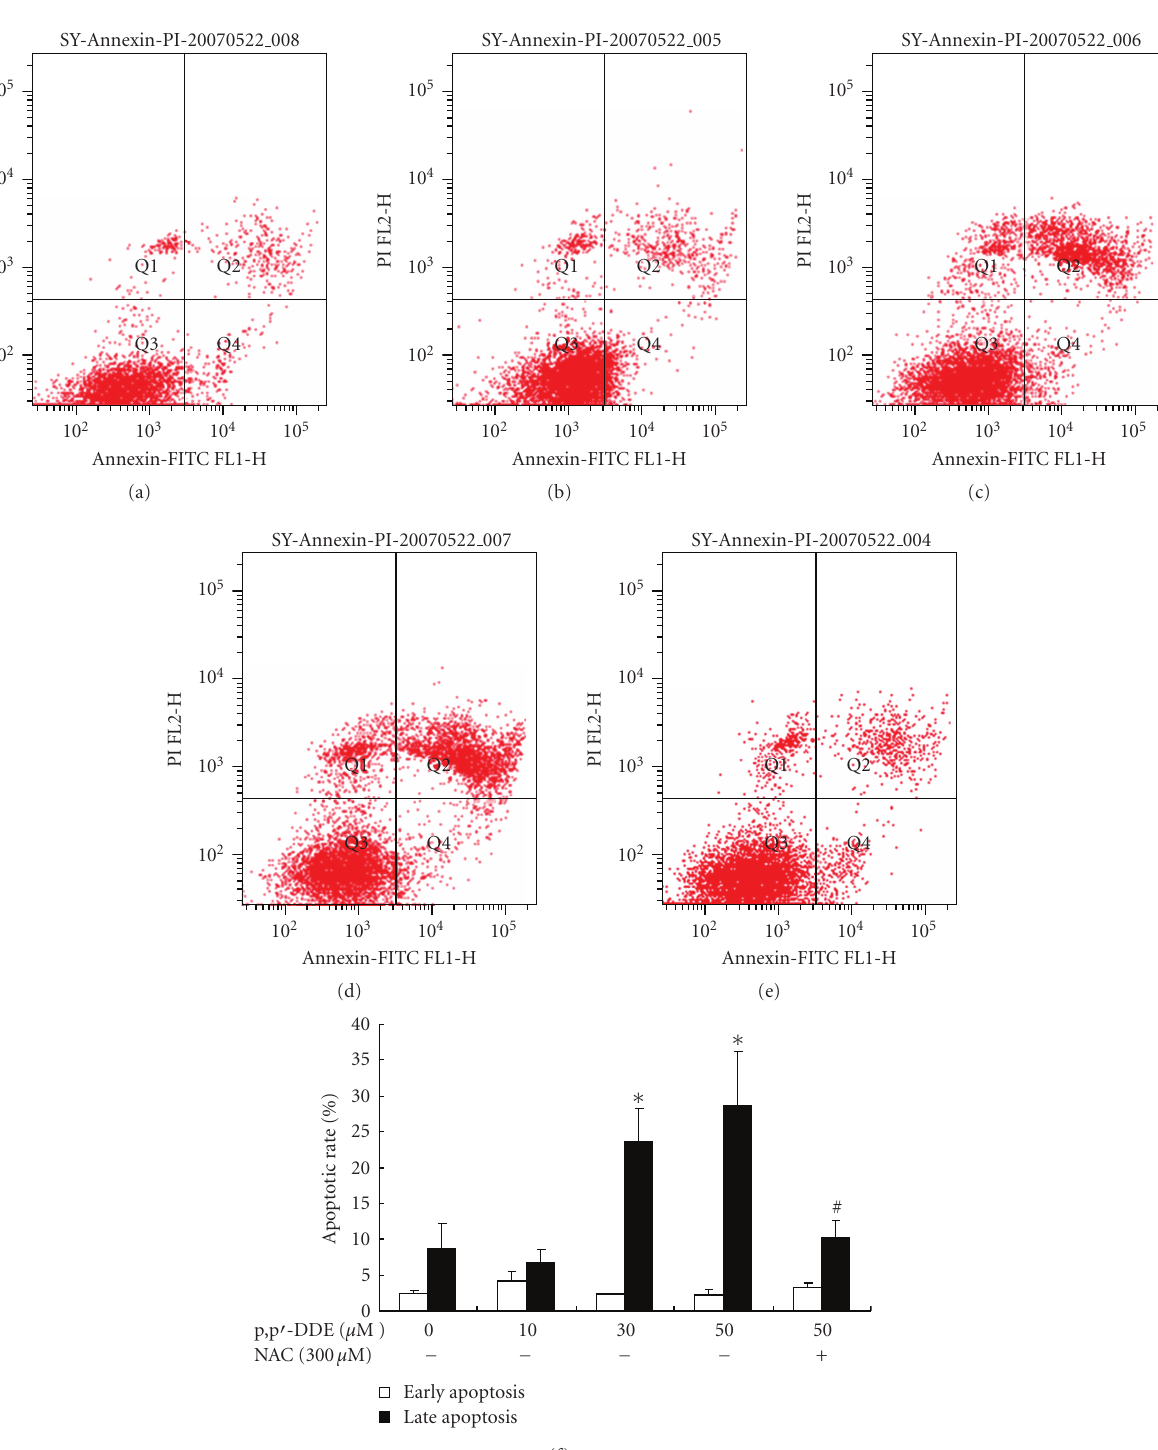
Figure 3: Representative plots of PI-Annexin staining of Sertoli cells treated with p,p (cid:2) -DDE with or without NAC. Sertoli cells were incubated with various concentrations of p,p (cid:2) -DDE (10, 30 or 50 μ M) for 24 hours. In other experiment, Sertoli cells were preincubated with 300 μ M NAC for 1 hour and followed by incubation with 50 μ M p,p (cid:2) -DDE for 24 hours. Then cell apoptosis was tested with flow cytometric analysis. (a)–(e) represented as treatment of 0 . 3% DMSO (a), 10 or 30 μ M p,p (cid:2) -DDE (b)–(c), 50 μ M p,p (cid:2) -DDE without or with NAC (d)–(e). (f) The apoptotic rate showed that 30 or 50 μ M p,p (cid:2) -DDE could induce apoptotic death of Sertoli cells blocked by NAC. Data are presented as mean ± SD of three independent experiments performed in triplicate. Significant di ff erence is ( ∗ ) P < . 05, compared with the control group and ( # ) P < . 05, compared with 50 μ M p, p (cid:2) -DDE